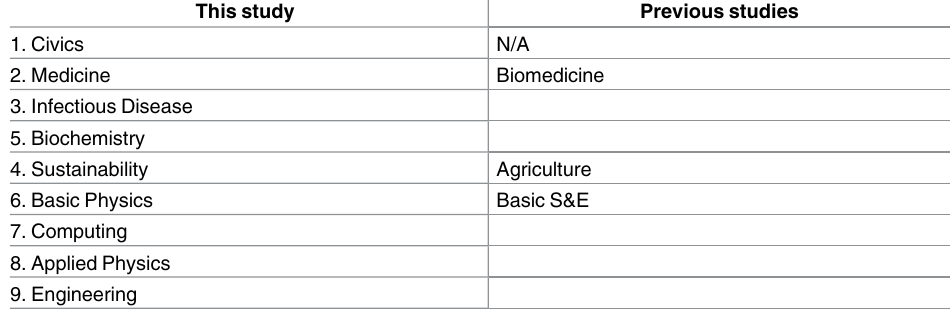
Table 6. Mapping of nine fields from this study to the three major strategies obtained by the majority of studies in Table 1. This